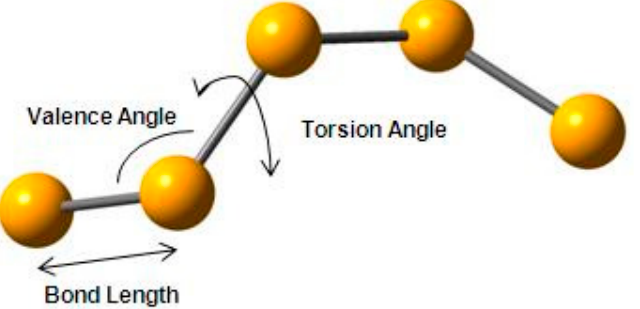
Figure 9. Schematic representation of vitreous selenium indicating the various structural parameters used in the modelling procedure.